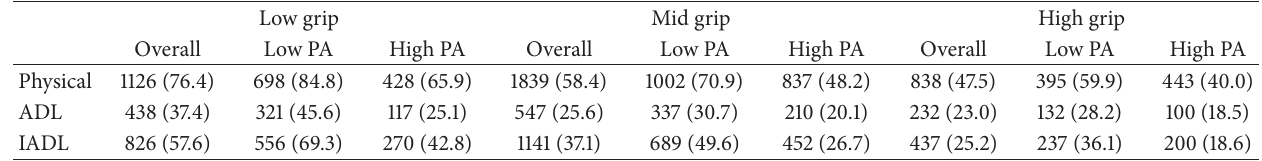
Table 2: Prevalence of physical, ADL and IADL limitations by grip tertiles and physical activity.